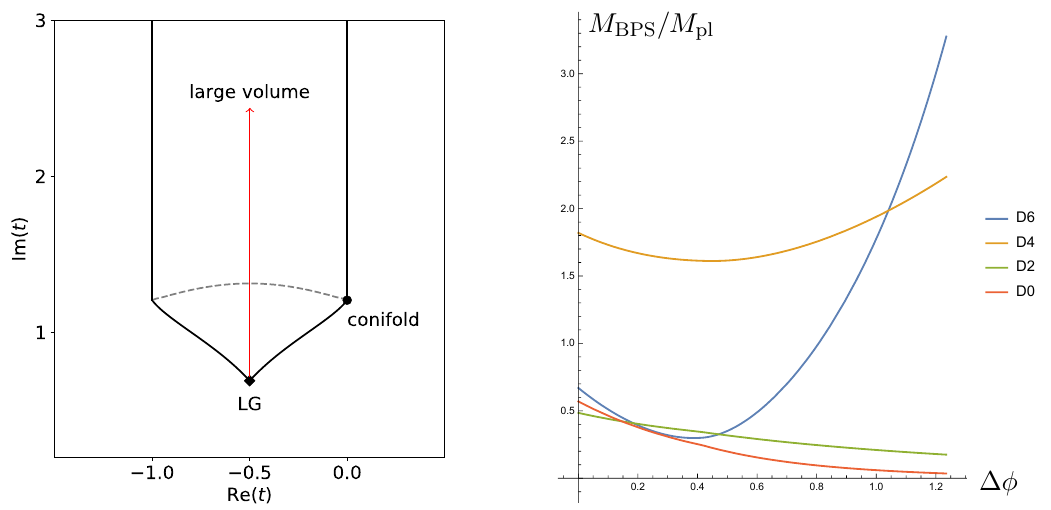
Figure 2 . Left: a geodesic (red) in the moduli space of the quintic [43, 56] starting at the mirror of the Gepner/LG point and approaching large volume. Right: value of the central charge for states with D 0 /D 2 /D 4 /D 6 charge along this trajectory. The exponential behavior ∼ exp( − ∆ φ ) is reached for ∆ φ ≈ 1 . Qualitatively similar behavior was observed for the mass scale of the KK tower in [43]. The existence or stability of a BPS state with these charges along the trajectory is not